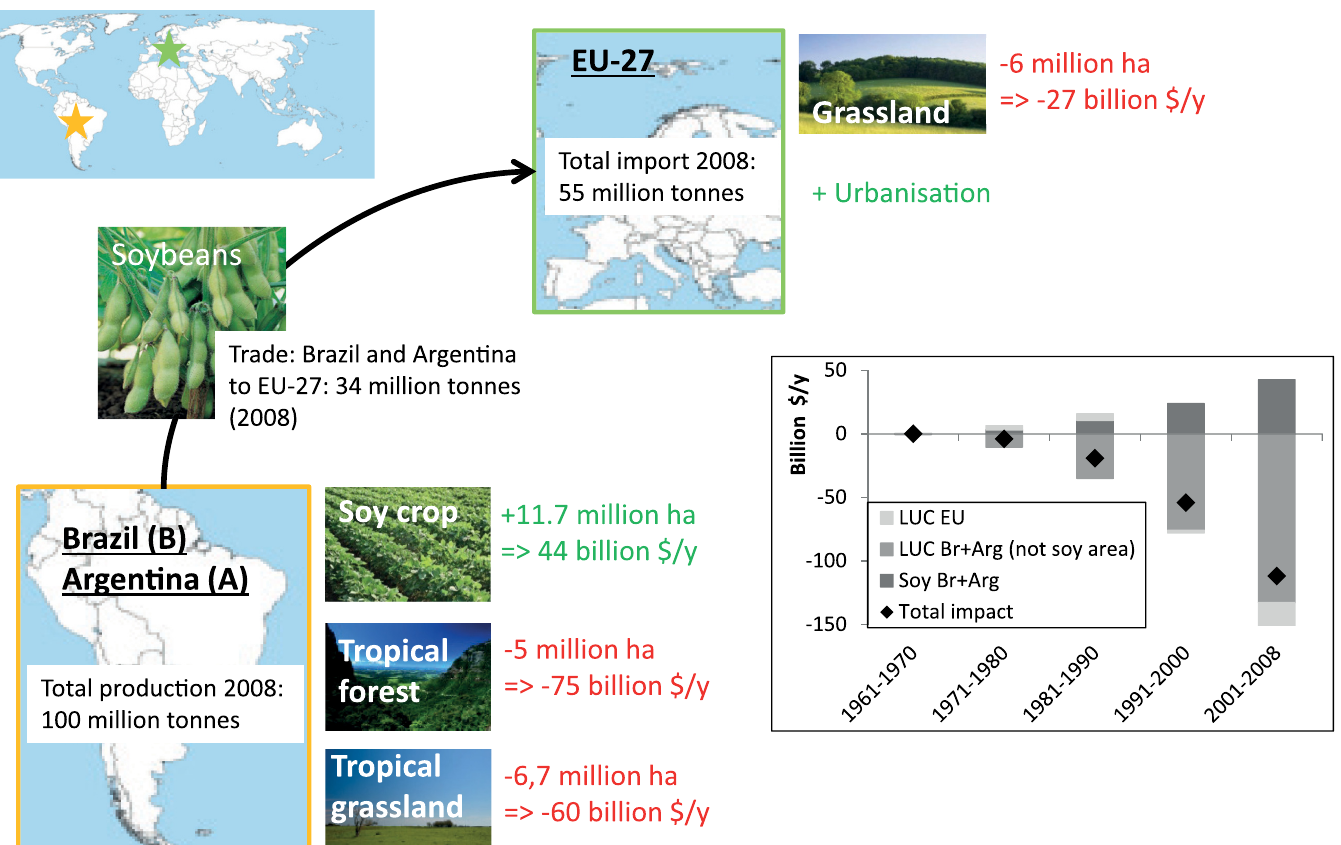
Fig 6. Global soybean market: soybean production in Brazil and Argentina, soybean export to EU-27 and soybean import by EU-27, 2008, in million metric tonnes [21]. Per land use type: area change 1961 – 2008 in million hectares [21] and socio-economic consequences in billion USD$/y (in 2008$). Graph: Annual environmental and socio-economic impact, average per time period, 1961 – 2008, billion